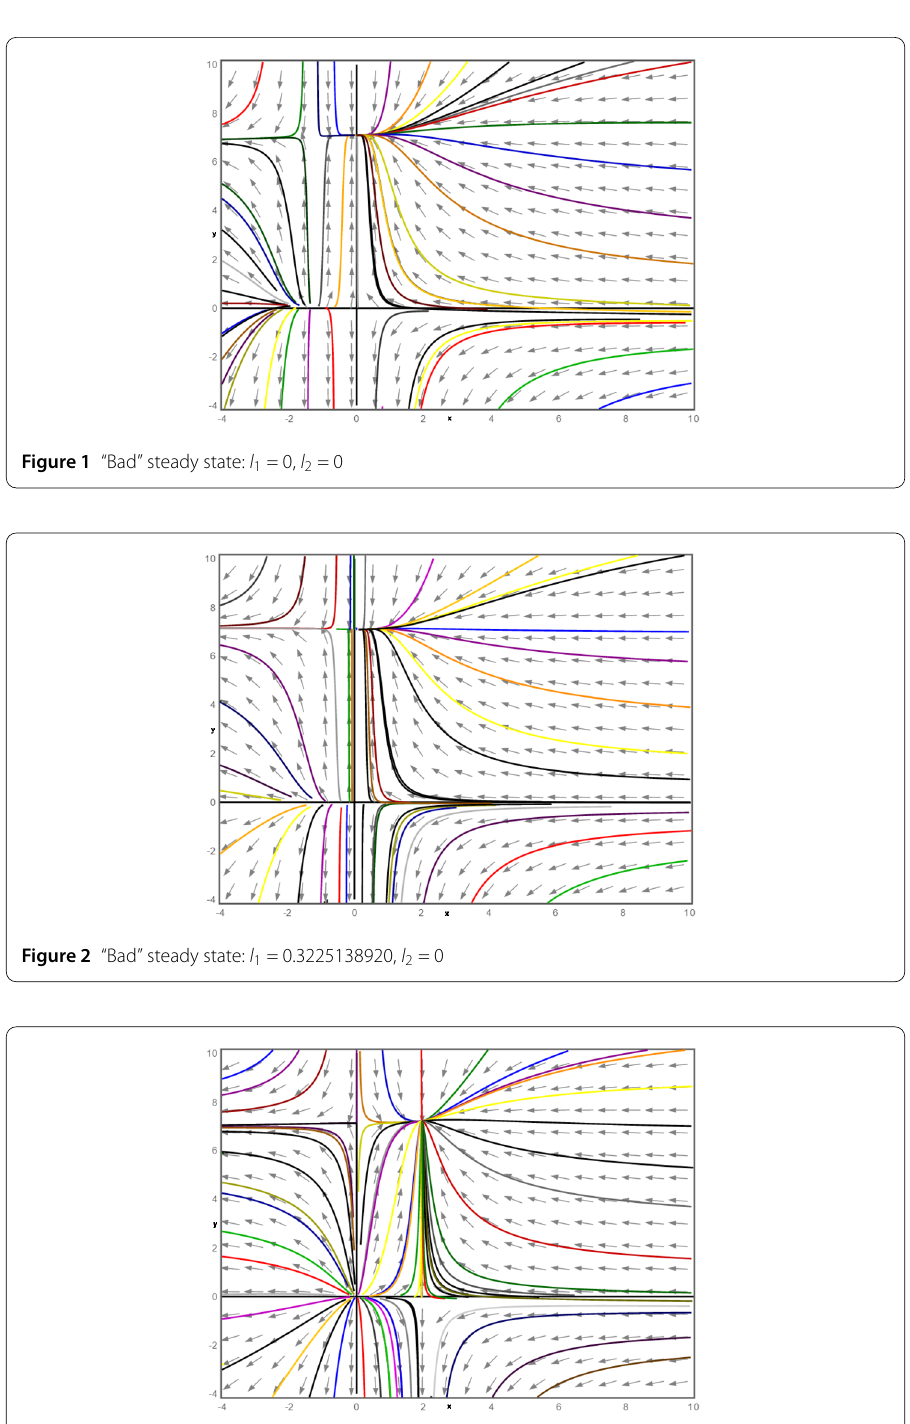
Example 3 In this example, we present the optimal harvesting policy for two species with different growth laws, the logistic and Gompertz laws. To illustrate the difference coming from the two-species growth curve, we assume that they have the same parameters K = 5, L = 8, r l = 5, r u = 5.35, s l = 4, s u = 4.25, m = 0.2, a = 0.8, θ = 0.3, δ = 0.05, p 1 = 4, p 2 =